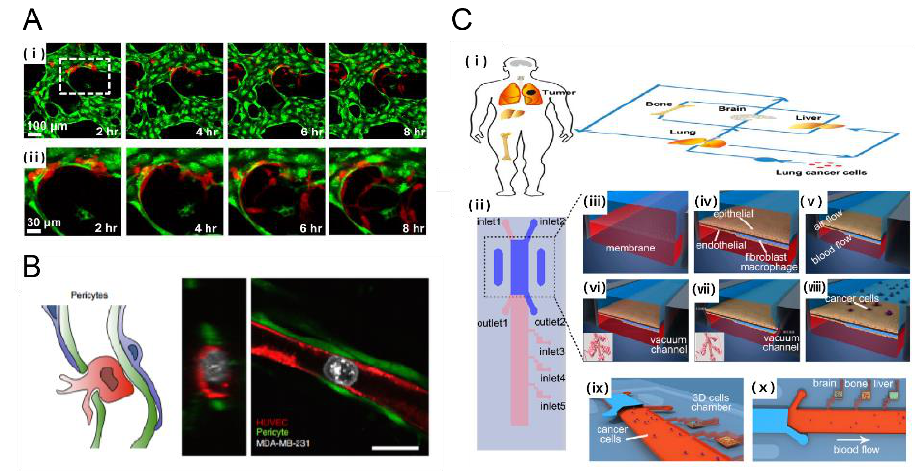
Figure 4. Metastasis on a chip. ( A ) A human 3D vascularized organotypic microfluidic system to study cancer cell extravasation (i) Cancer cell extravasation was monitored in real time within a vascular network (ii) magnified image [43]. Scale bar: 100 μm; ( B ) Human umbilical vein pericytes were cocultured with human umbilical vein endothelial cells to form pericyte-covered lumens. The extravasation rate from HUVEC-only cultures was significantly higher when compared to HUVEC-pericyte coculture [44]. Scale bar: 20 μm; ( C ) Design of biomimetic multi-organ chip (i, ii) multi-organ